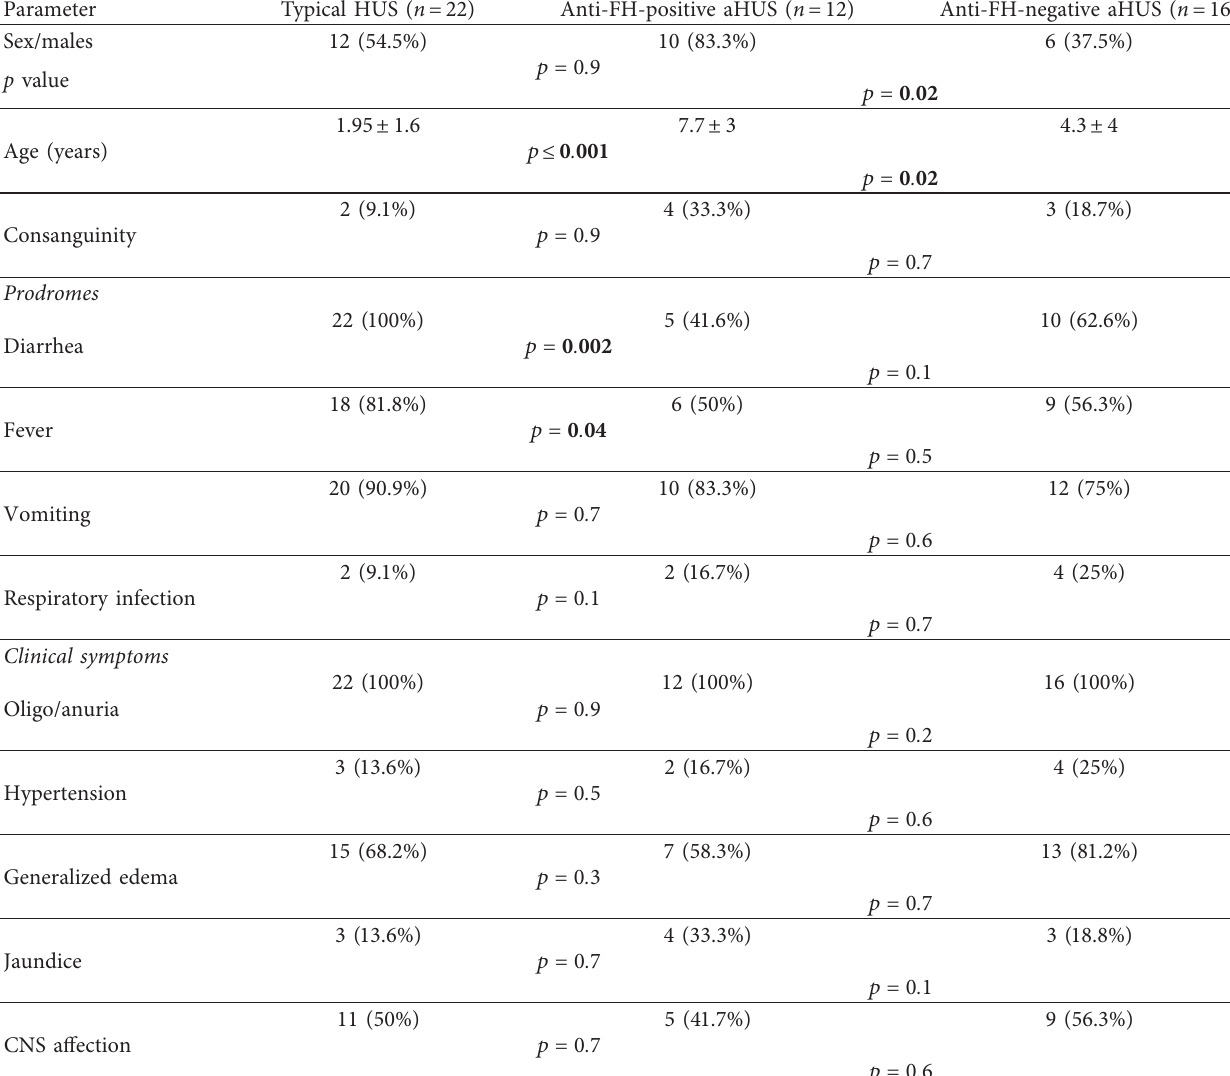
Table 1: Demographic features and clinical findings in HUS